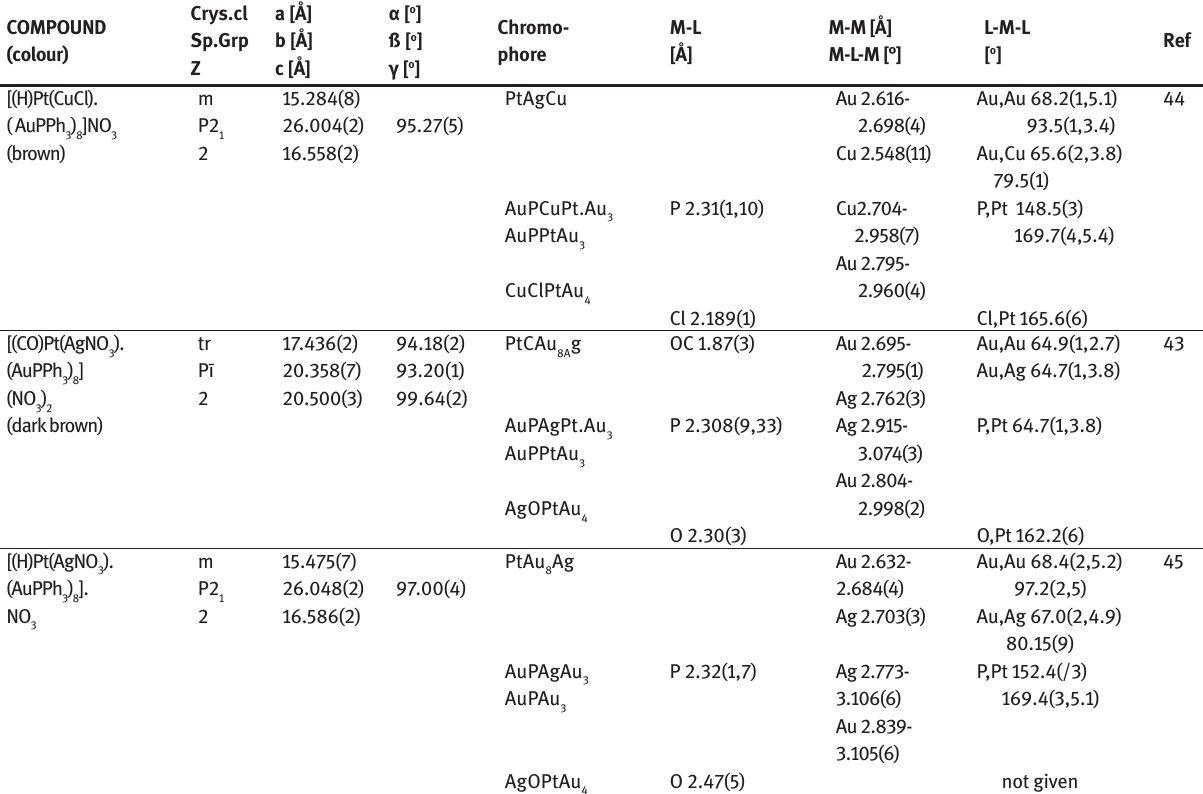
Table 3: Crystallographic and structural data for heterodecanuclear platinum clusters a Continued